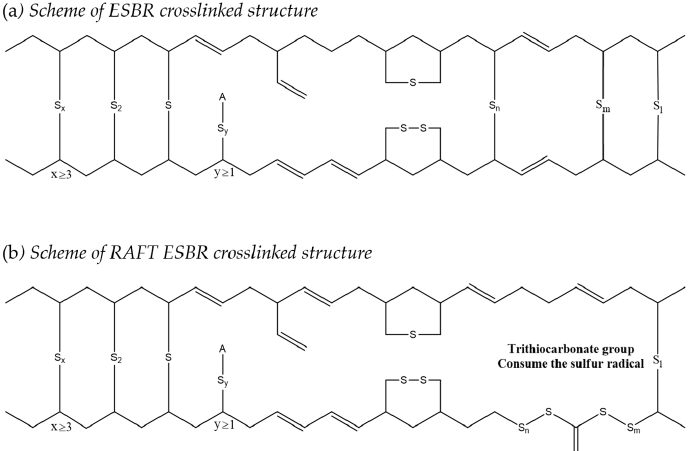
Figure 5. Crosslinked structure schemes of ( a ) emulsion styrene butadiene rubber (ESBR) and ( b ) reversible addition ‐ fragmentation radical transfer ESBR (RAFT ESBR) vulcanizates.